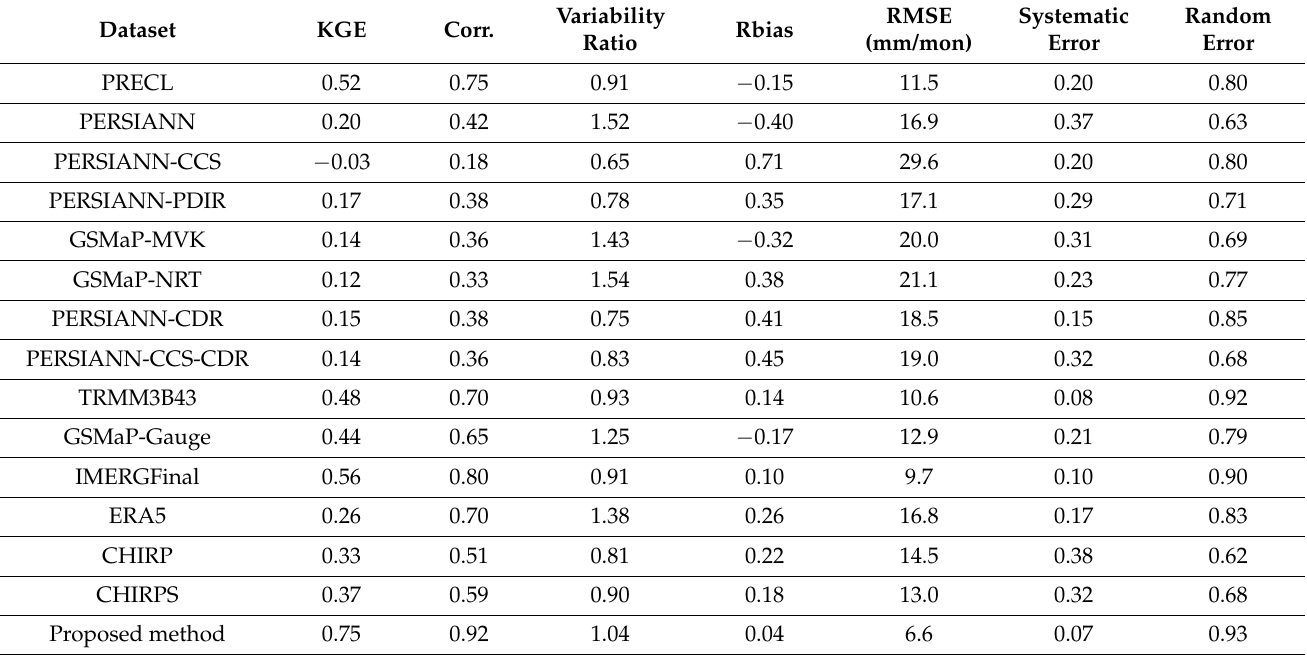
Table 3. Results of the accuracy evaluation of different precipitation products based on precipitation map obtained from interpolation